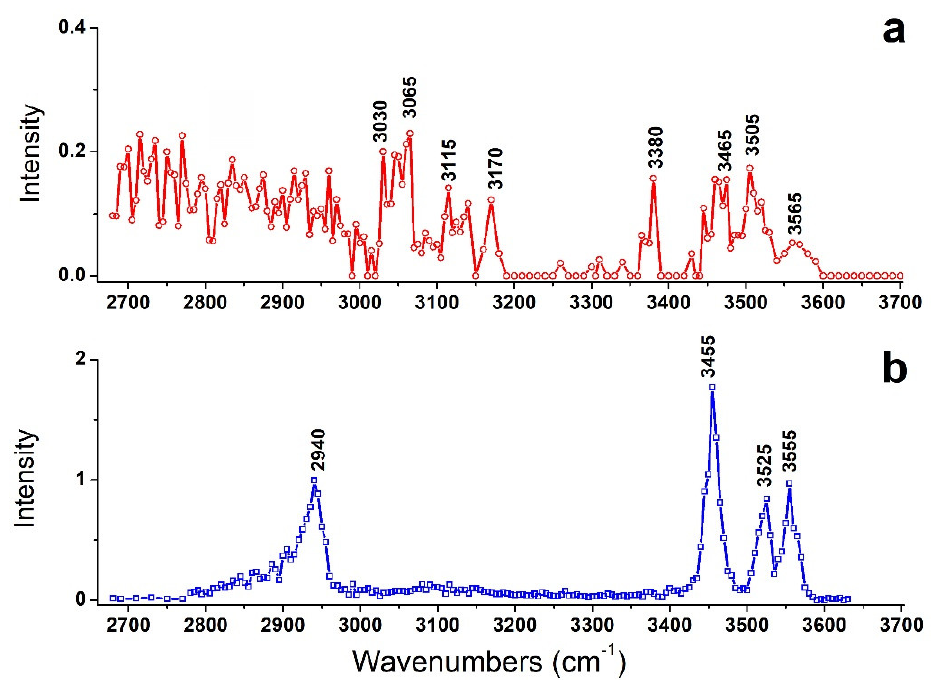
Figure 1. IRMPD spectra of ( a ) [Arg+Rb+K−H] + and ( b ) [Arg+Rb] + . The latter is taken from ref